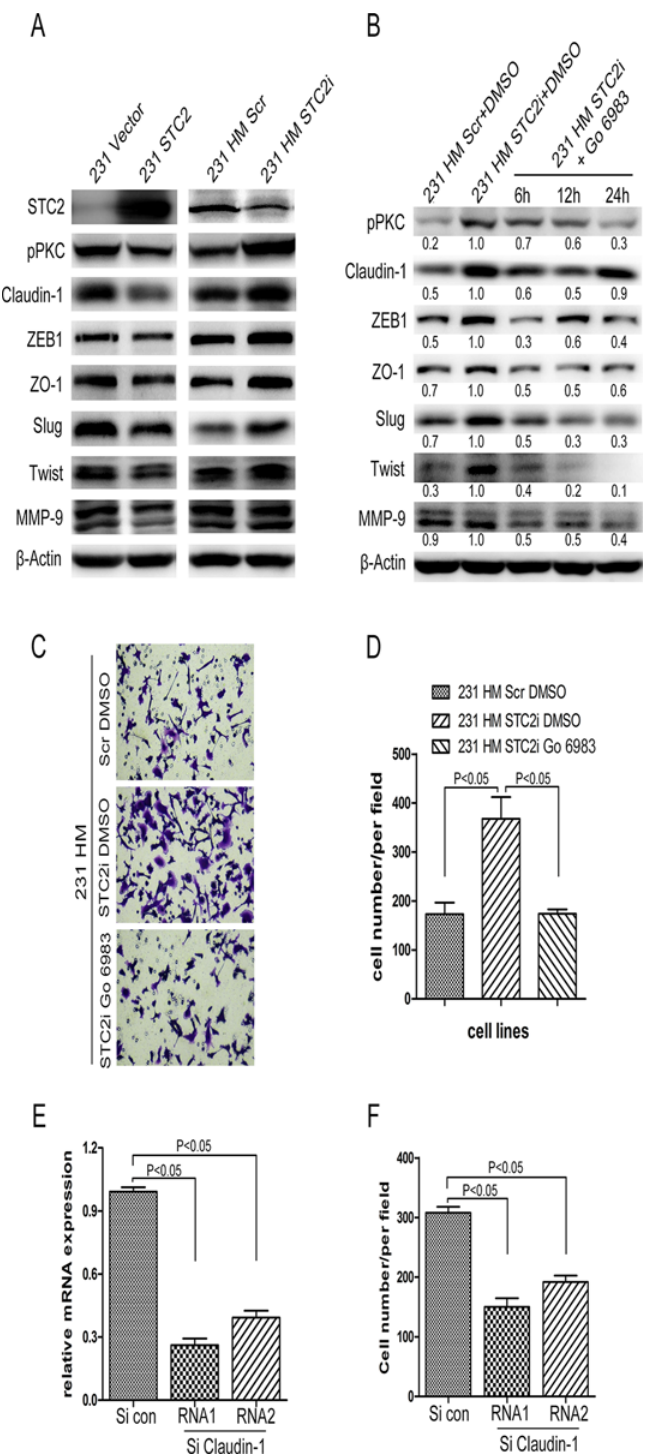
Fig 5. STC2 regulates EMT program through PKC/Claudin-1 pathway. A , Immunoblot analysis of molecules associated with PKC/Claudin-1 signal pathway and EMT program. pPKC, Claudin-1, ZEB1, ZO-1, Slug, Twist, MMP9 were measured by Western blotting with the corresponding antibodies. β -Actin was used as the loading control. B , Immunoblot analysis and quantitative analysis of pPKC, Claudin-1, ZEB1, ZO-1, Slug, Twist, MMP9 after treatment with 1 μ M Go 6983 in 231 HM STC2i cells at different time point. C-D ,